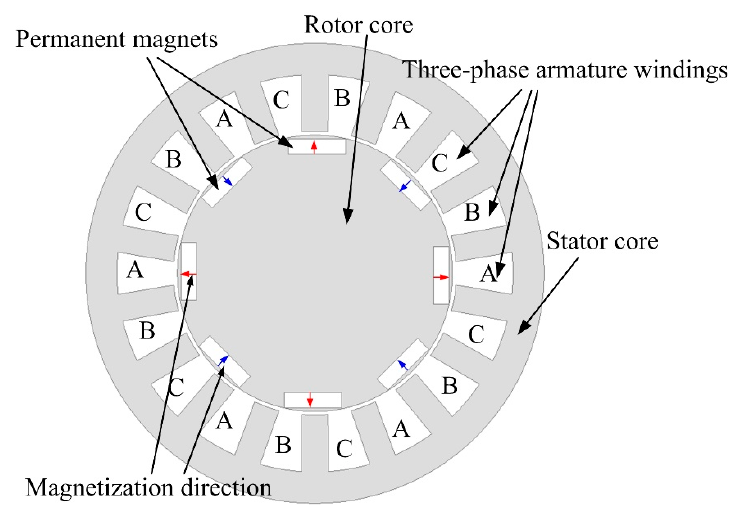
Figure 2. The structure of an interior-type PMSM (radial profile).